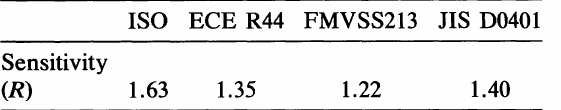
Table 1. Sensitivity Indices of Several